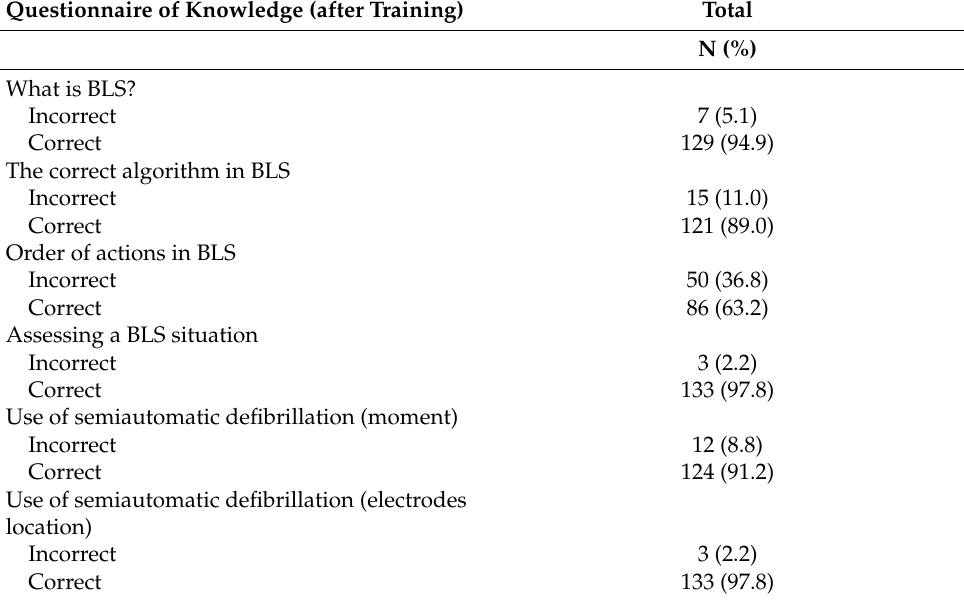
Table 2. BLS in pregnant women questionnaire after